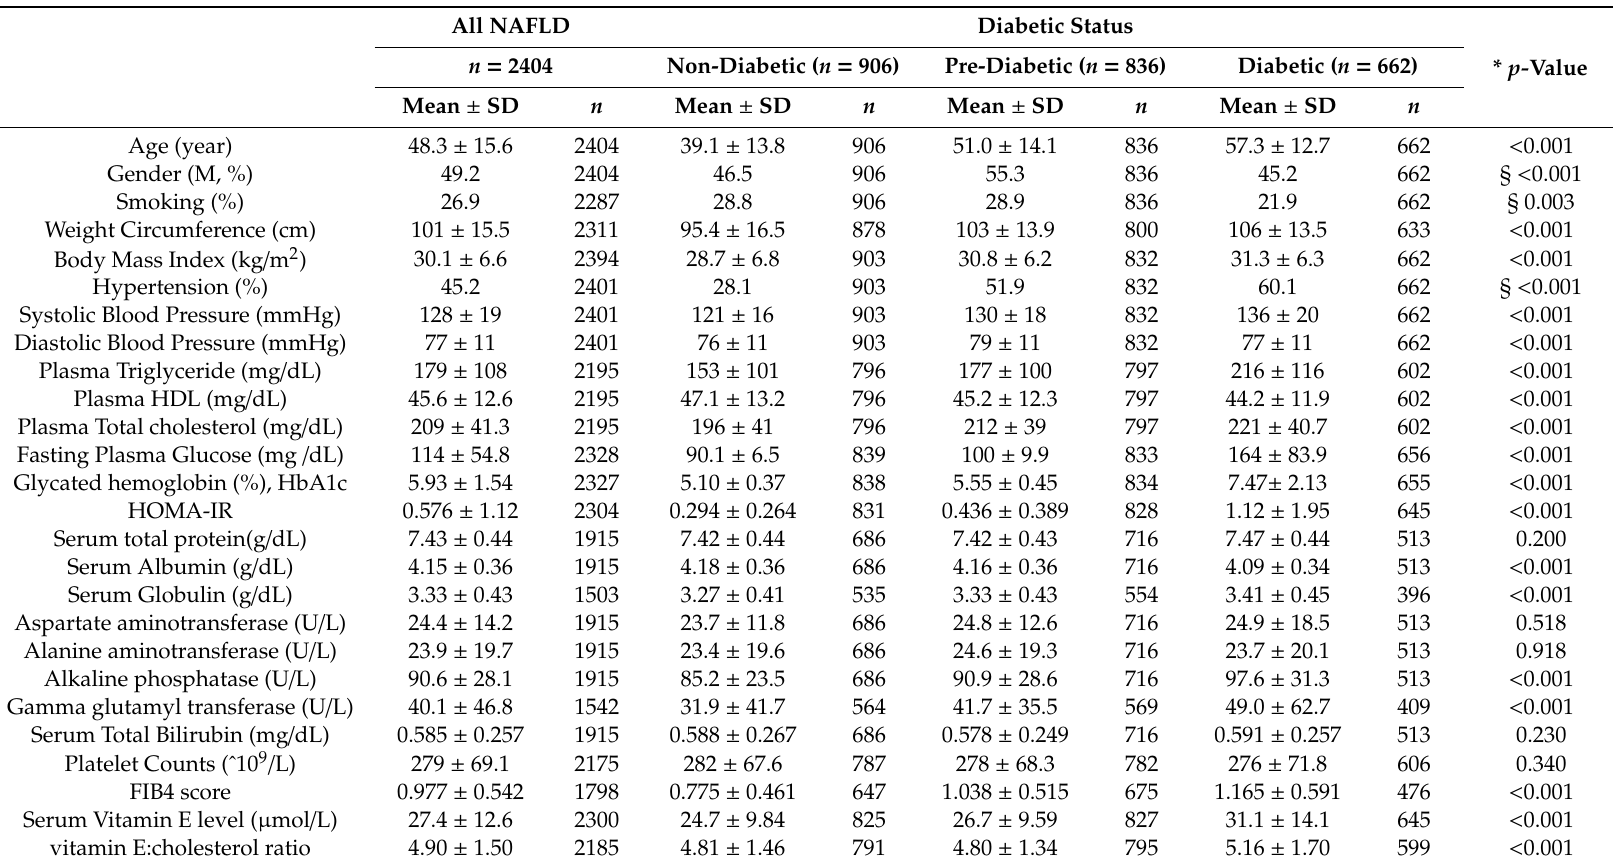
Table 1. Characteristics of all NAFLD subjects and of three subgroups stratified by diabetic